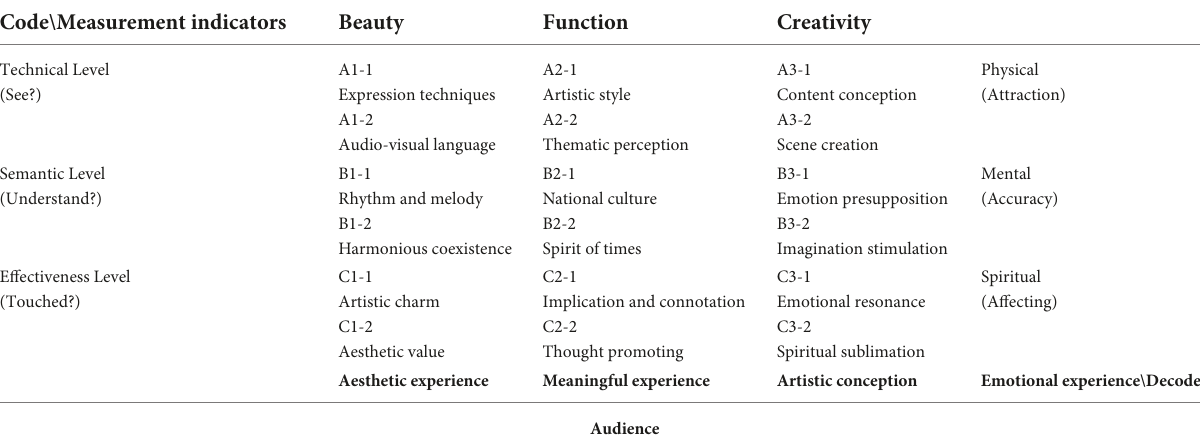
TABLE 1 Emotional design evaluation matrix of audio-visual